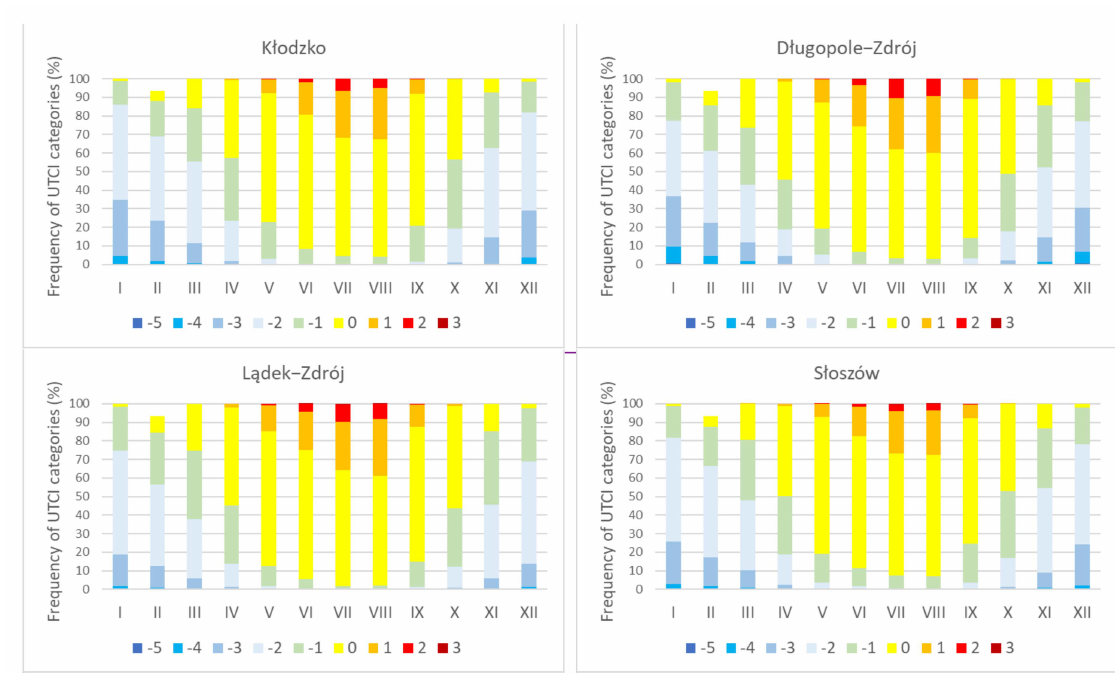
Figure 4. Frequency of UTCI categories in 1971–2010 in Kłodzko Land, based on 12:00 UTC data (UTCI categories: extreme cold stress ( − 5), very strong cold stress ( − 4), strong cold stress ( − 3), moderate cold stress ( − 2), slight cold stress ( − 1), no thermal stress (0), moderate heat stress (1), strong heat stress (2), and very strong heat stress